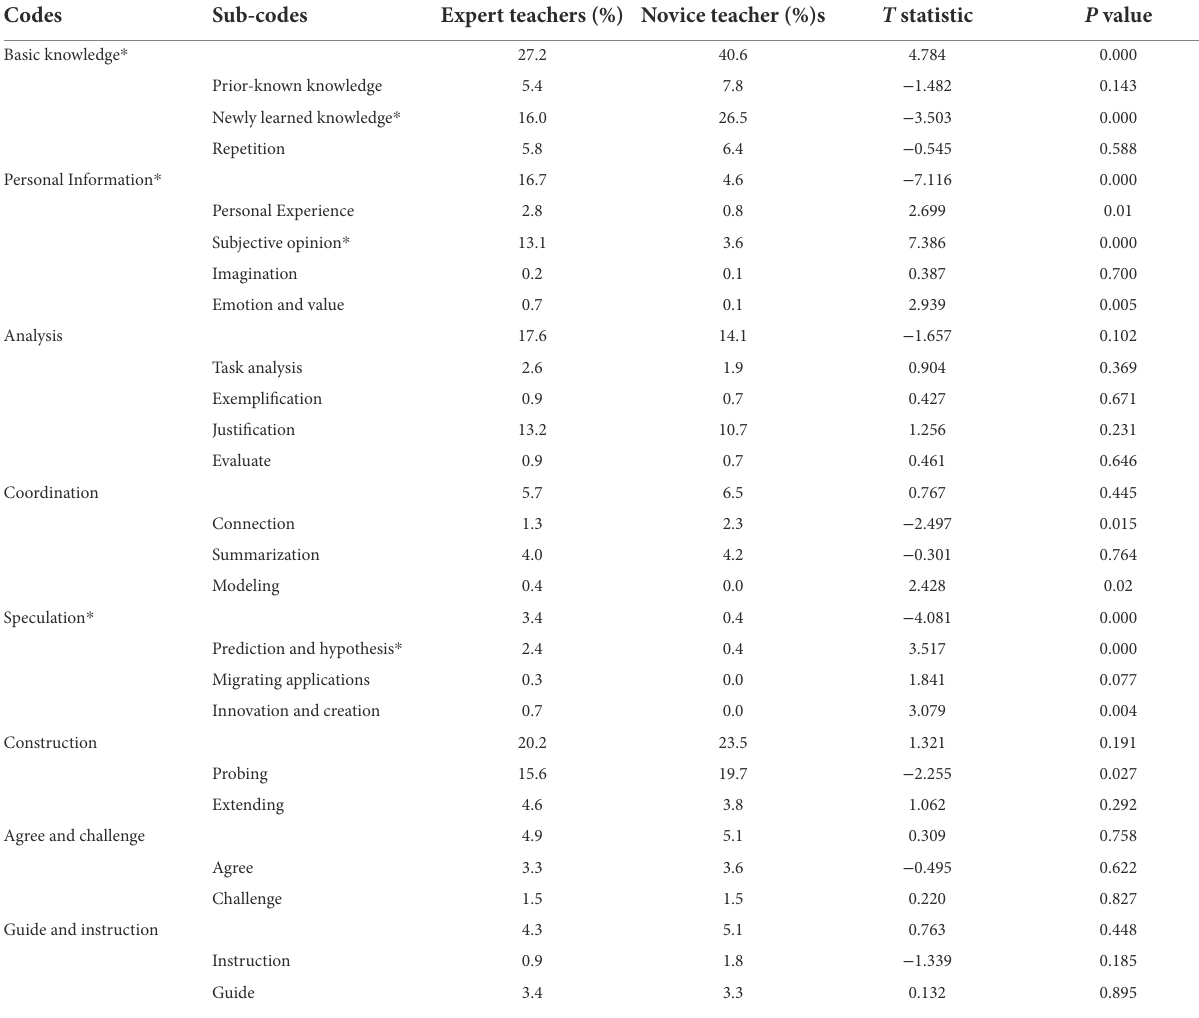
TABLE 1 T -test regarding the average percentages of each code between expert and novice teachers.